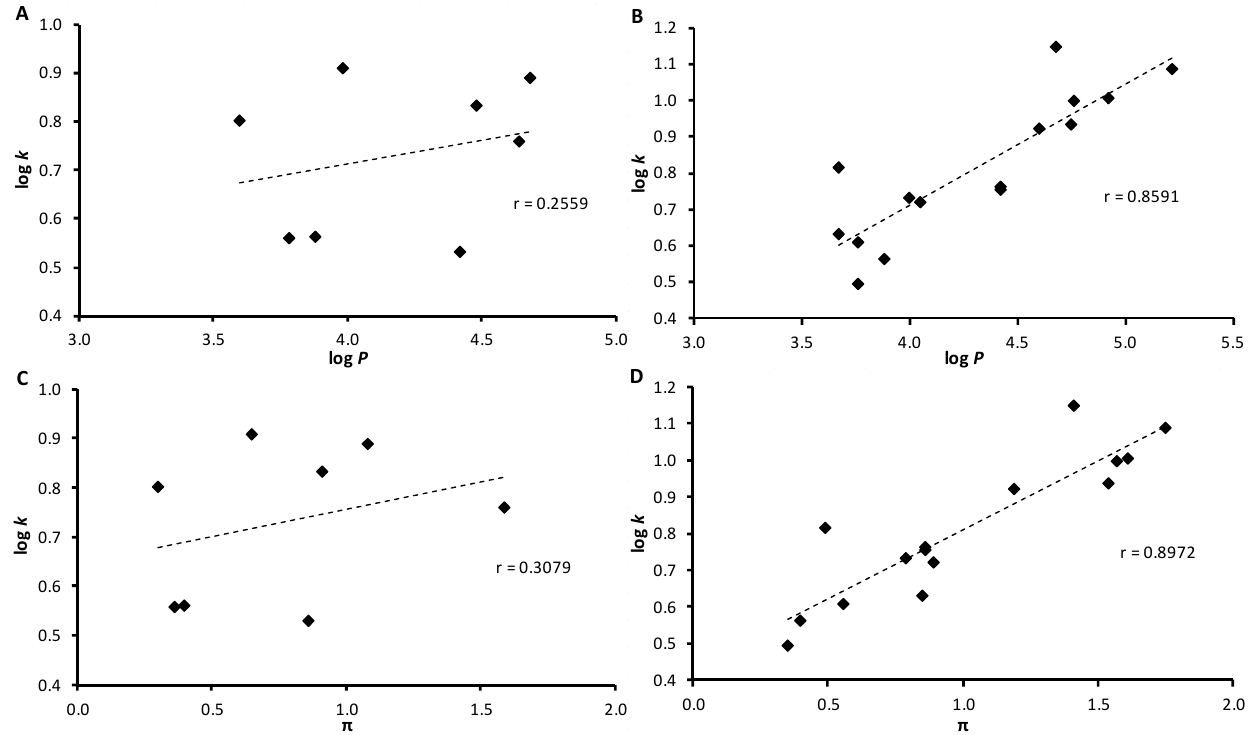
Figure 1. Match of experimentally found log k values with calculated log P data of ortho -substituted ( A ) and meta - and para -substituted derivatives ( B ) and with calculated distributive parameter π (hydrophobicity contribution of the substituent in position 1 of naphthalene) of ortho -substituted ( C ) and meta - and para -substituted derivatives ( D ).